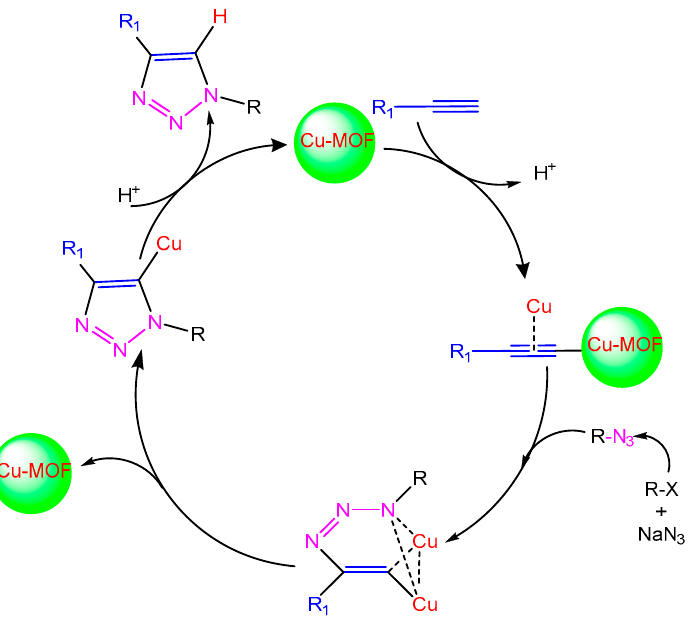
Figure 6. Plausible reaction mechanism for CuAAC using Cu-MOF as a catalyst [95].